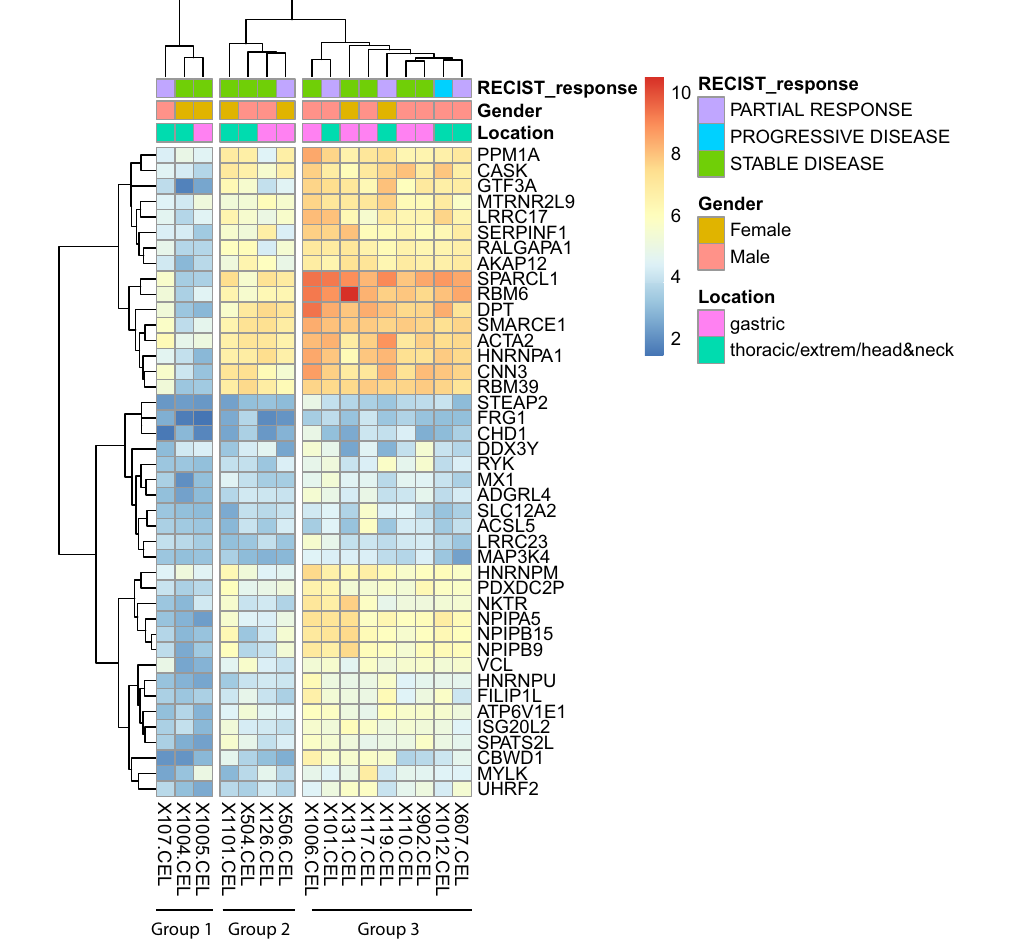
cluster annotation, samples are clustered, with k-mean clustering method, according to three features: gender (m/f), location of the tumor and type of response [RECIST classi fi cation: Partial Response (PR), Stable Disease (SD) or Pro- gression Disease (PD)]. Source data are provided as a Source Data fi